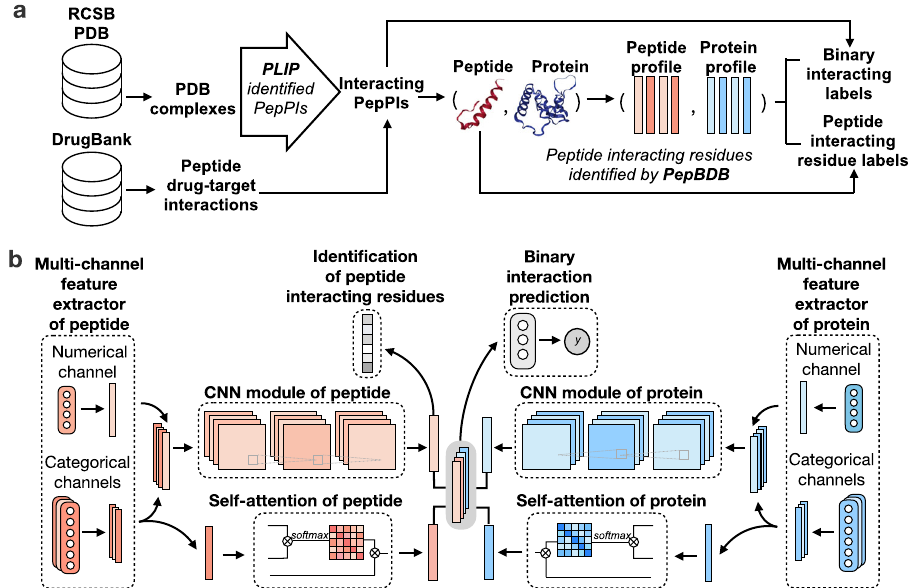
Fig. 1 The work fl ow and architecture of CAMP. a Work fl ow of data curation and label extraction. We fi rst extracted all PDB complexes containing peptides as ligands from the RCSB PDB 21,22 and all peptide drugs with corresponding targets from DrugBank 23 – 26 . Then for the peptide – protein pairs from the PDB, we used PLIP 28 to identify the interacting pairs by detecting whether there existed non-covalent interactions between them. Next, we generated sequence-based feature pro fi les for peptides and proteins, including residue-level structural and physicochemical properties, intrinsic disorder tendencies of peptides and proteins, and protein evolutionary information. We also downloaded the corresponding labels of peptide-binding residues from PepBDB 29 . Such residue-level labels and pairwise binary interactions were regarded as the multi-level supervised information for CAMP. b Network architecture of CAMP. Given the peptide feature pro fi les and the protein pro fi les of an input pair, the numerical features, i.e., the evolutionary protein PSSM and the intrinsic disorder tendency of each residue in the peptide or protein sequence are processed by the numerical channels of the feature extractors. The categorical features, i.e., the raw amino acids, secondary structures, polarity, and hydropathy properties of the peptide or protein are processed by three categorical channels. Next, the outputs of these channels are concatenated together and then fed into CNN modules, and the outputs of the amino-acid representations of the peptide and the protein are also fed into self-attention modules to learn the importance of individual residues (i.e., the contributions of individual residues to the fi nal prediction). After that, the outputs of self-attention modules and CNN modules are concatenated together to predict a binding score for each peptide – protein pair through three fully connected layers and a binding score for each residue from the peptide sequence using the output of the CNN module of the